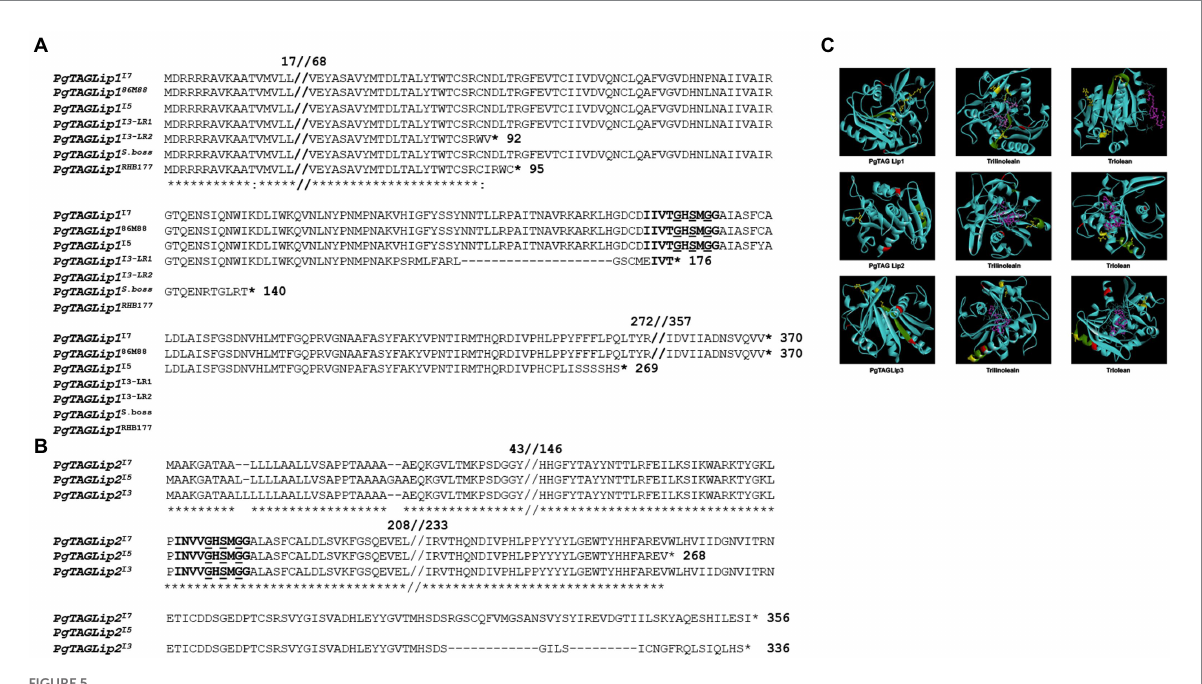
FIGURE 5 Structural variations of selected TAG lipases. (A) Comparative amino acid sequence alignment of Pgl_GLEAN_10023115 (PgTAGLip1) in high (I7, 86 M88, I5) and low rancidity genotypes (I3, Super Boss, RHB177). The LID domain is in bold, and the Lip serine active motif (GxSxG) is in bold and underlined. (B) Comparative amino acid sequence alignment of PgTAGLip2 in high rancid (I7 and I5) and low rancid (I3) lines. The LIP domain is bold and Lip serine active motif (GxSxG) is bold and underlined. (C) Predicted protein models and docking affinities of three PgTAGLips (PgTAGLip1, PglTAGLip2, and PgTAGLip3) with triolein and trilinolein. The predicted substrate binding is shown in a ball and stick model, with dashed pink lines denoting the hydrogen bonds. The putative LID domain GxSxG motif is in green, the catalytic triad is in yellow with ball and stick, the putative glycosylation sites are in red, and the ligand ball and stick is in